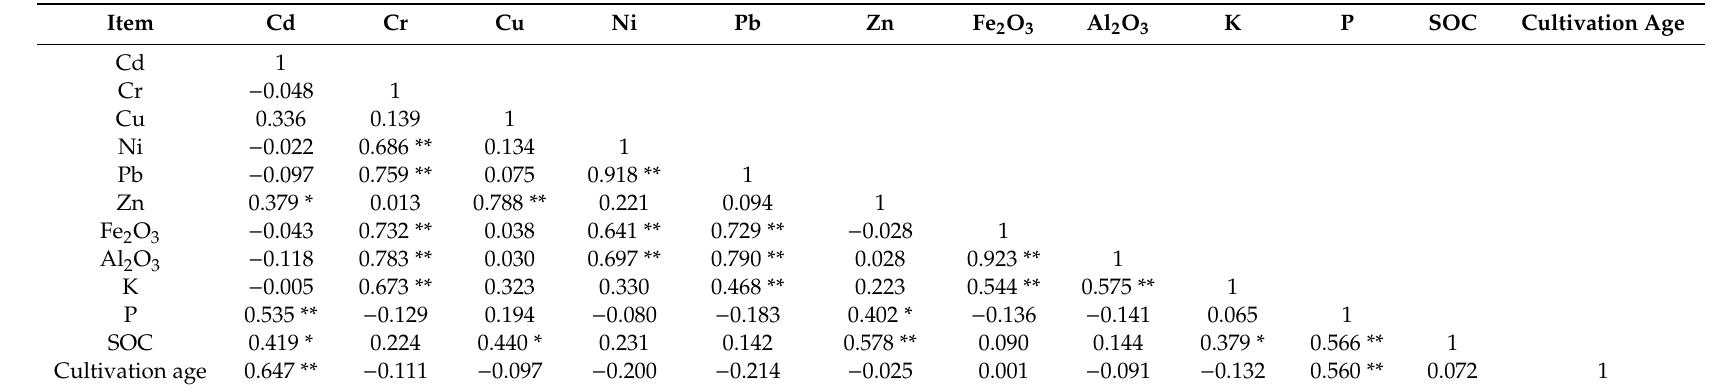
Table 5. The Pearson Correlation coe ffi cients (r) between the HM contents and soil property parameters in greenhouse soils in